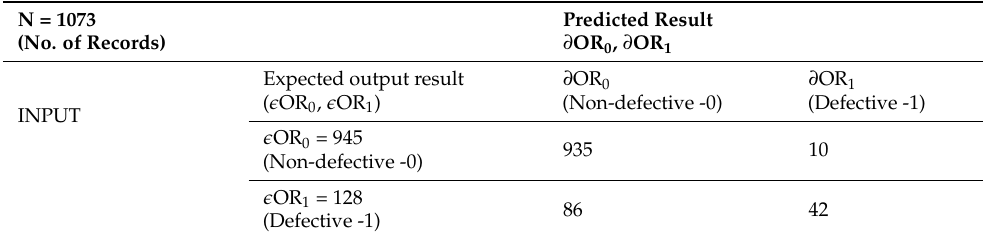
Table 9. Fused testing.